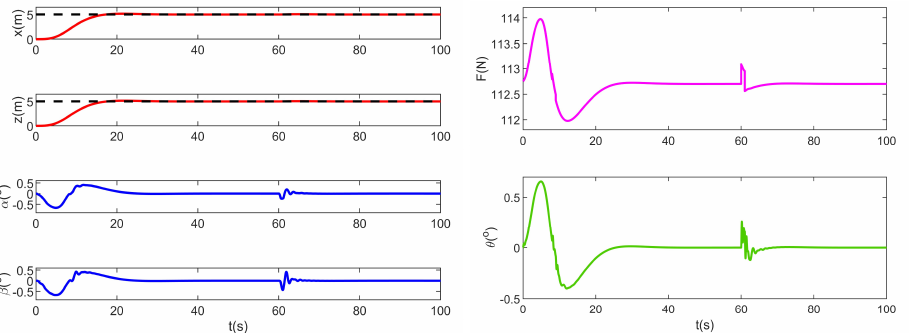
Figure 7. Simulations results for external